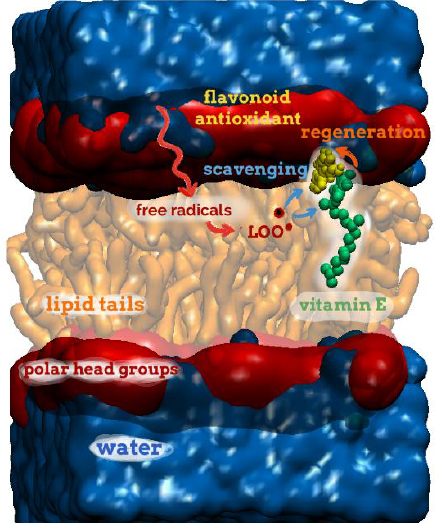
Scheme 5. Schematic view of a lipid bilayer membrane under oxidative stress in the presence of two antioxidants located in different regions, namely, in contact with the polar head group region or embedded in between the lipid tails for both the prototypical flavonoid antioxidant (quercetin, in yellow) and vitamin E (green). Due to possible noncovalent interaction between both antioxi- dants, regeneration processes are possible by electron or H-atom transfer, see text. The positioning of both antioxidants is obtained from MD simulations, according to the methodology described in Fabre G. et al.